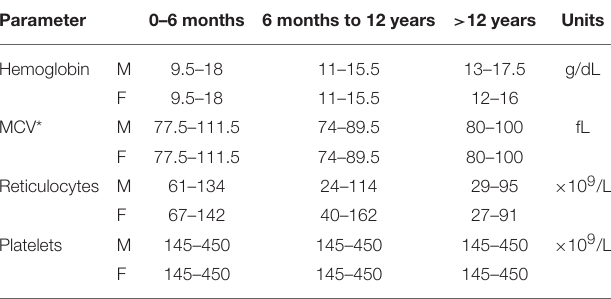
TABLE 1 | Parameter thresholds used by the diagnostic CoDysAn algorithm.